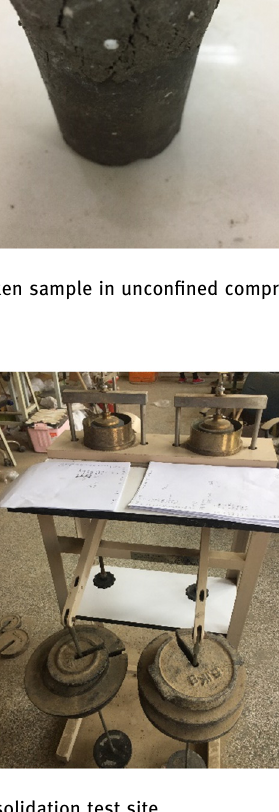
Figure 4: The consolidation test site.